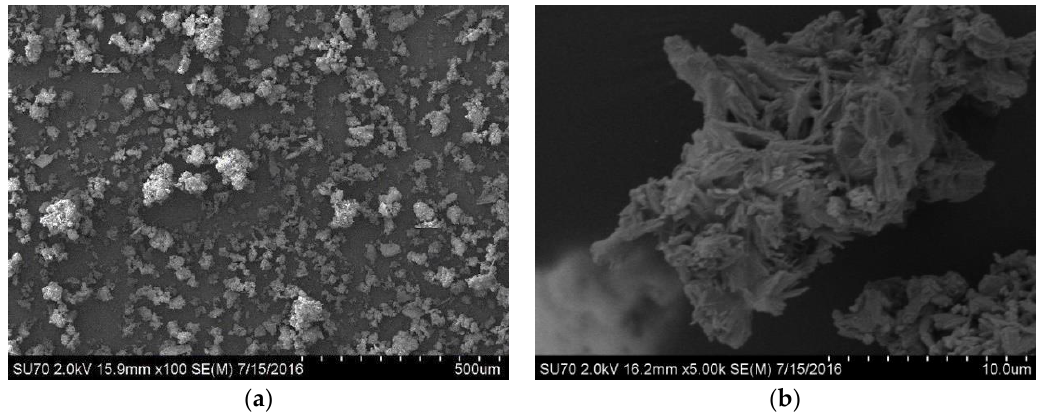
Figure 1. Powder X-ray diffractogram of metal-organic framework (MOF)-1.